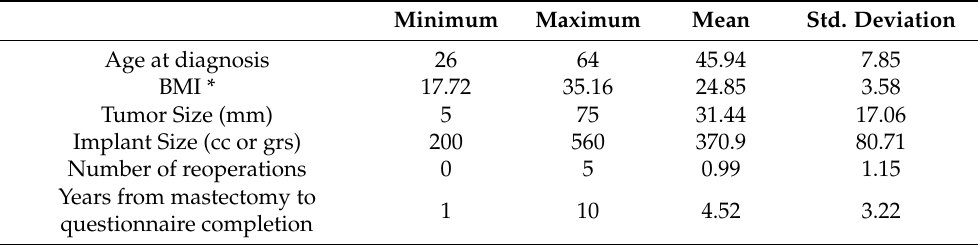
Table 1. Demographic characteristics and preoperative conditions (I).